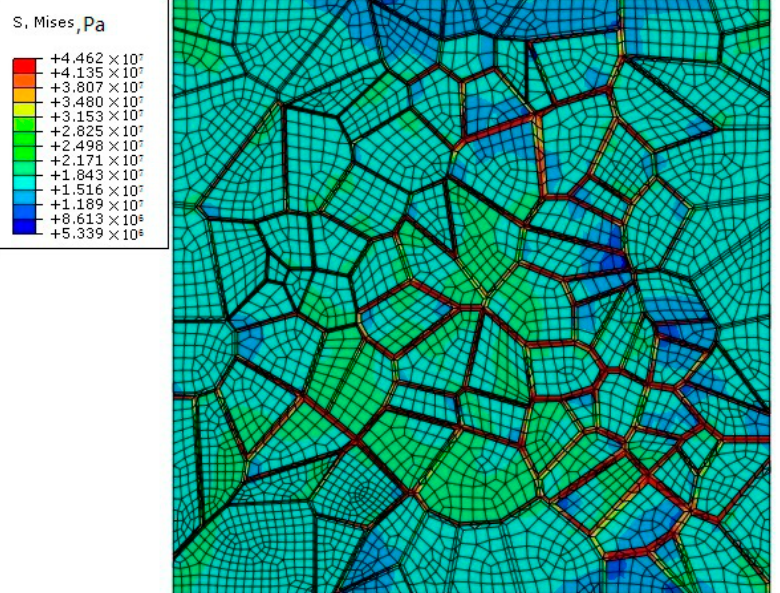
Figure 11. Stress distribution in the polycrystalline model without defects.